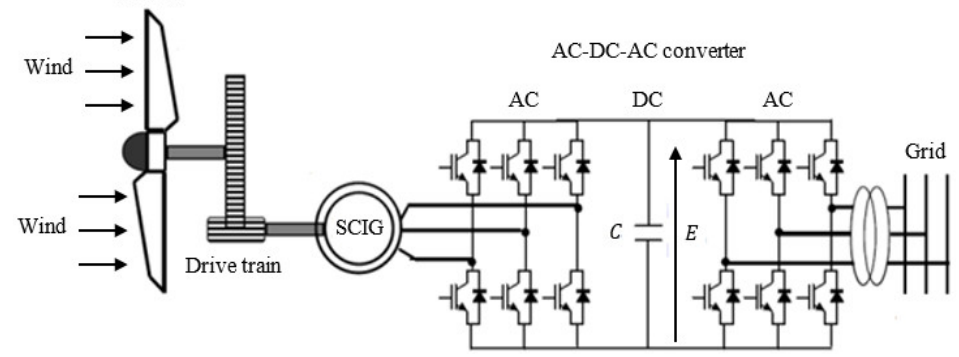
Figure 2. Wind turbine with the SCIG system.